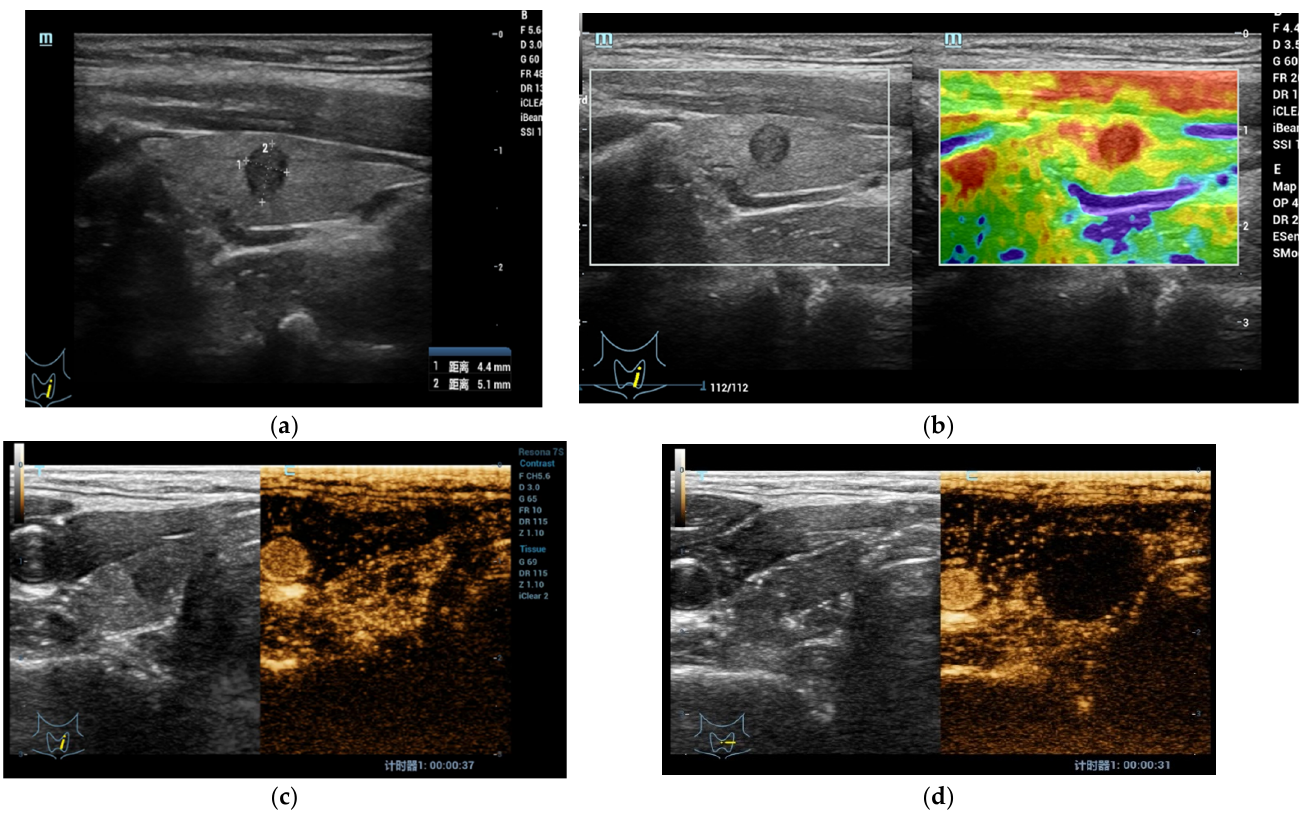
Figure 1. ( a ) At B-mode US, the shape of the lesion appeared taller-than-wide, hypoechoic with regular margins without internal microcalcifications (EU-TIRADS 5); ( b ) At qualitative USE evaluation, the lesion appeared stiff (completely red in the color box); ( c ) At CEUS evaluation, the lesion appeared richly vascularized similar to surrounding thyroid parenchyma without strong wash-out. At FNAC the lesion was classified as Tir 5. ( d ) After Radiofrequency Ablation, the lesion and surrounding parenchyma does not show enhancement in the CEUS mode.